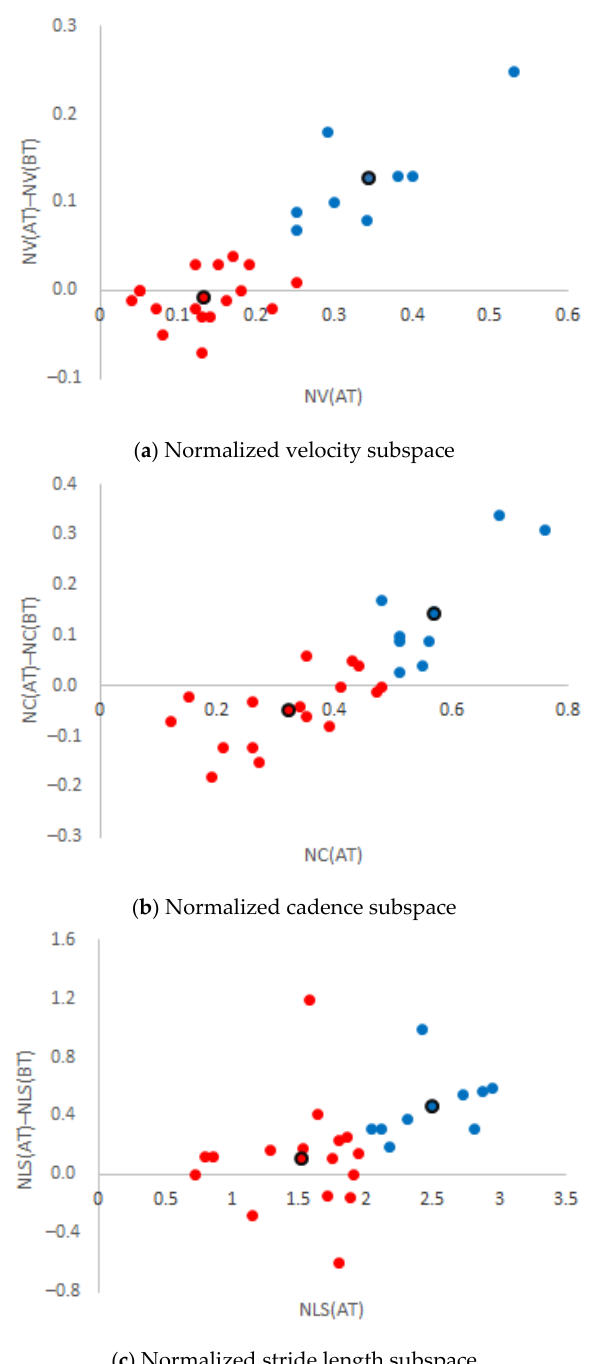
Figure 1. The result of clustering for 2 clusters. The points with a black outline represent cluster